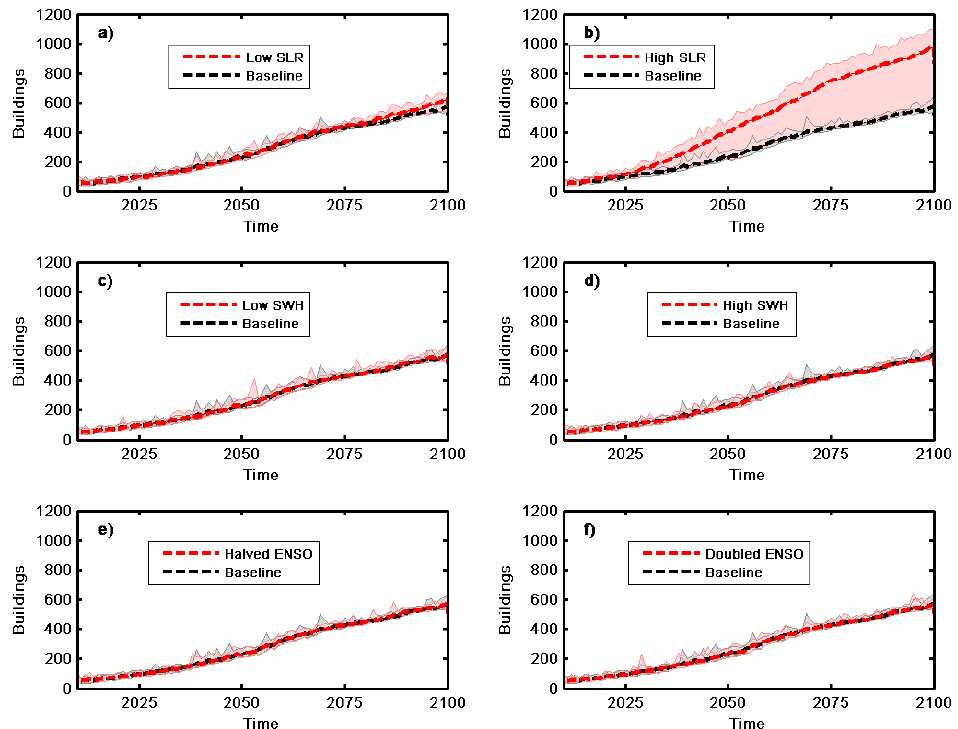
Figure 6. Number of buildings impacted by erosion through time under each of the six climate drivers (panels a – f ) compared to the baseline. Dashed lines indicate the decadal mean of all simulations. Bounds represent the minimum and maximum decadal means.